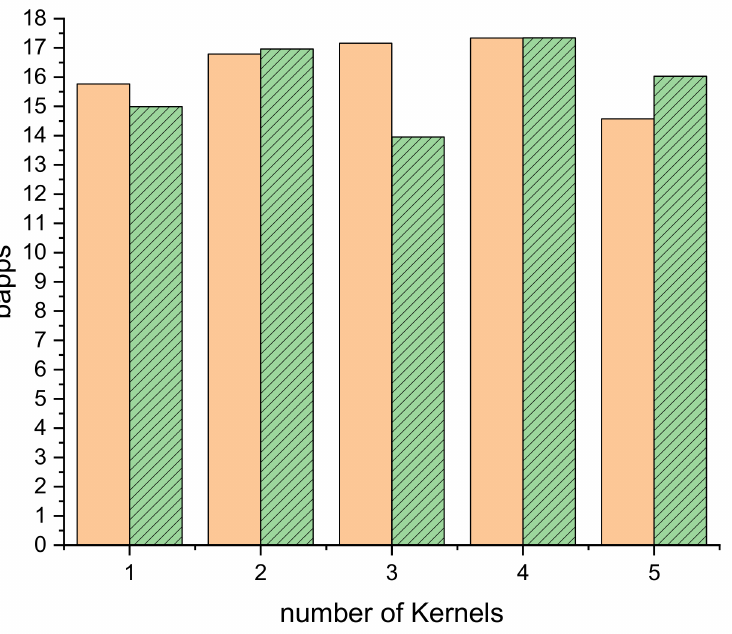
Figure 8. Bapps for OmpSs@FPGA designs with different number of Distance kernels for 2 million particles. Full orange column running at 250 MHz and dashed green column running at 300